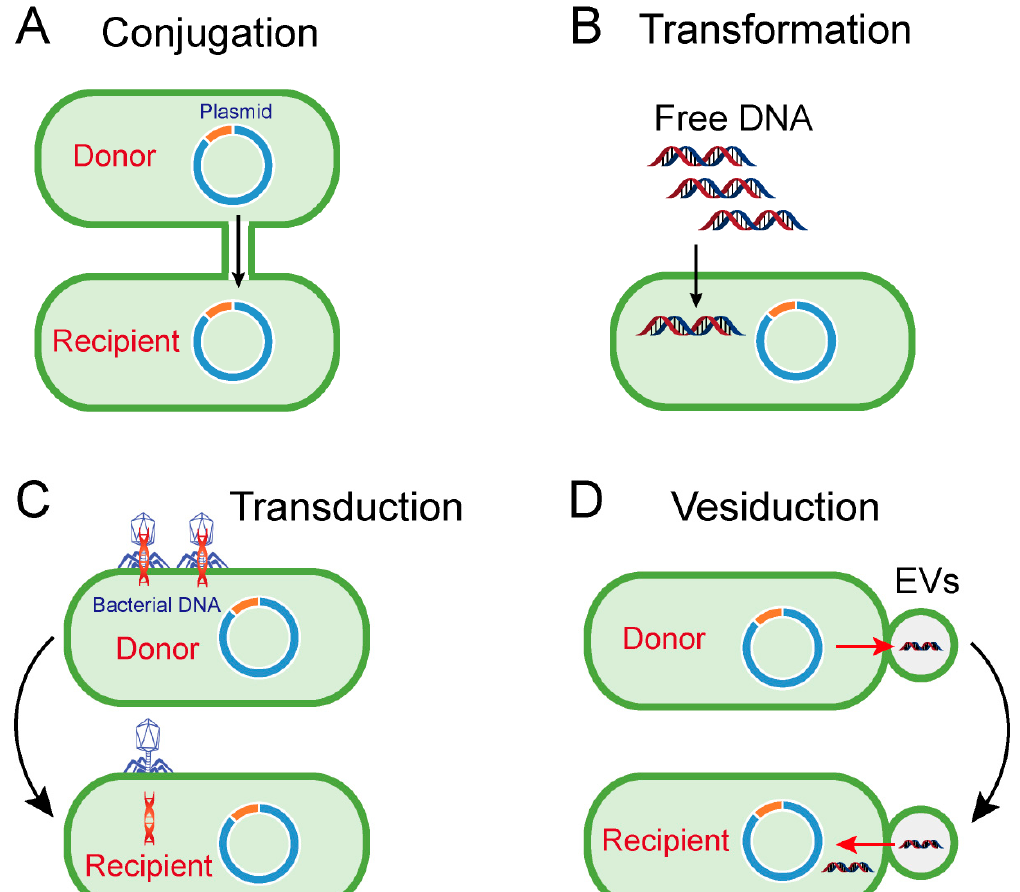
Figure 1. Pathways of horizontal gene transfer. (A) Conjugation is the process of DNA transfer from donor cell to recipient cell via cell-to cell contact. (B) Transformation represents the uptake and integration of naked fragments of extracellular DNA by recipient cells. (C,D) Transduction and vesiduction refer to the transfer of bacterial DNA (red DNA strand) by bacteriophages (C) or extracellular vesicles (EVs, D).